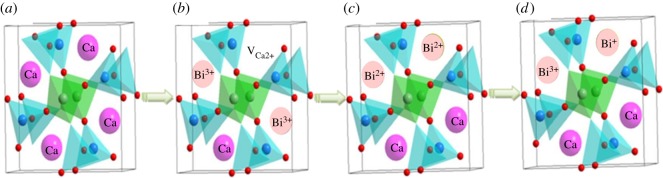
(a) The Ca2Al2SiO7 host structure; (b) the incorporation of the Bi3+ ions; (c,d) the incorporation of the Bi2+ ions; the incorporation of the Bi3+ and Bi+ ions into the host structure for charge compensation [5].